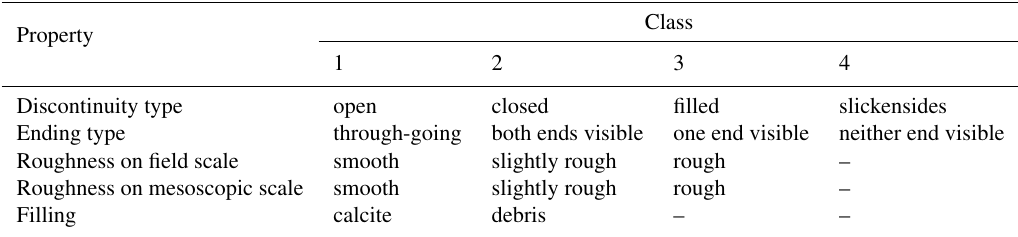
Table 1. Overview of the documented discontinuity properties and their classification as defined for scanline surveys (modified from Markovaara-Koivisto and Laine, 2012). In our observations we distinguish between open, closed, and filled discontinuities. Open discon- tinuities are those that are neither filled with calcite nor with debris. Closed discontinuities are in fact joints. Filled discontinuities are not categorized as closed ones, since both discontinuity surfaces are not in direct contact with each other. Filled discontinuities can either be filled with calcite or with debris (i.e. veins). The roughness of the discontinuities was classified on field scale ( > 10 − 1 m) and on a mesoscopic scale ( (cid:54) 10 − 1 m). Class Property 1 2 3 4 Discontinuity type open closed filled slickensides Ending type through-going both ends visible one end visible neither end visible Roughness on field scale smooth slightly rough rough – Roughness on mesoscopic scale smooth slightly rough rough – Filling calcite debris –